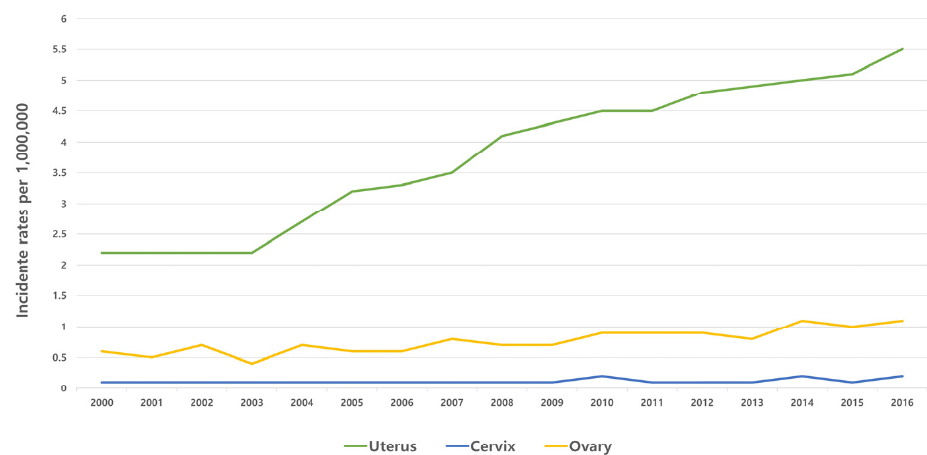
Figure 1. The annual trends in the incidence of gynecologic carcinosarcoma (2000 to 2016). The five-year CSS rates according to sites of origin, including the uterus, cervix, and ovary, were 39.9%, 33.1%, and 25.8%, respectively (Figure 2). The 1-year survival rate was lowest for patients with cervical carcinosarcoma (cervix, 55.1%; uterus, 70.5%; ovary, 62.3%), whereas the 5-year survival rate of those with ovarian carcinosarcoma was lowest (ovary, 25.8%; uterus, 39.9%; cervix, 33.1%). Uterine carcinosarcoma showed the best prognosis compared with other gynecologic carcinosarcoma ( p < 0.001).